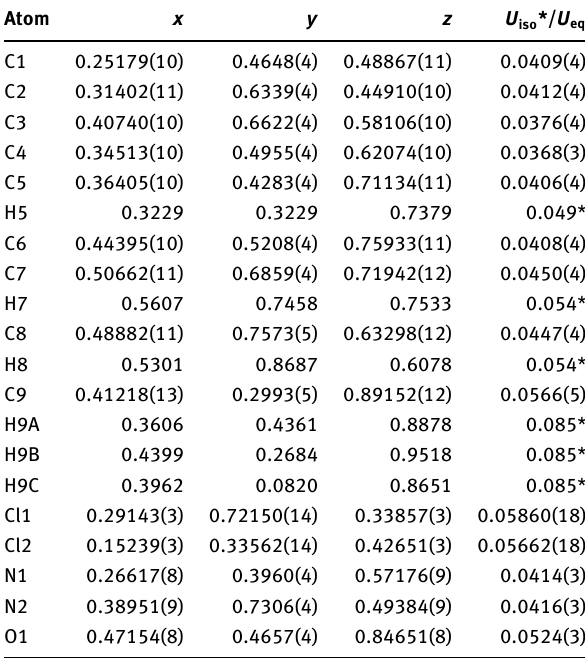
Table 2: Fractional atomic coordinates and isotropic or equivalent isotropic displacement parameters (Å 2